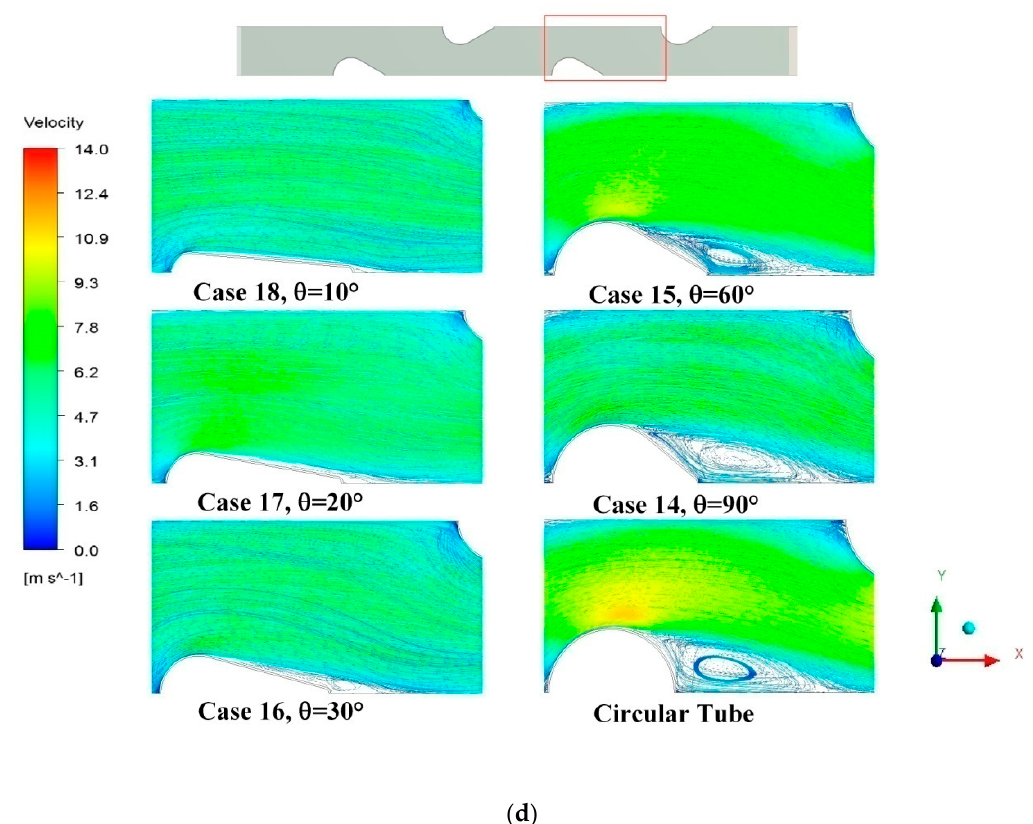
Figure 8. ( a ) E ff ect of di ff erent angle on the j factor at di ff erent Reynolds numbers, ( b ) E ff ect of di ff erent Figure 8. ( a ) Effect of different angle on the j factor at different Reynolds numbers, ( b ) Effect of angle on the f factor at di ff erent Reynolds numbers, ( c ) E ff ect of di ff erent angle on the JF factor at different angle on the f factor at different Reynolds numbers, ( c ) Effect of different angle on the JF di ff erent Reynolds numbers, ( d ) The flow field of di ff erent angle as the perimeter keep factor at different Reynolds numbers, ( d ) The flow field of different angle as the perimeter keep constant.